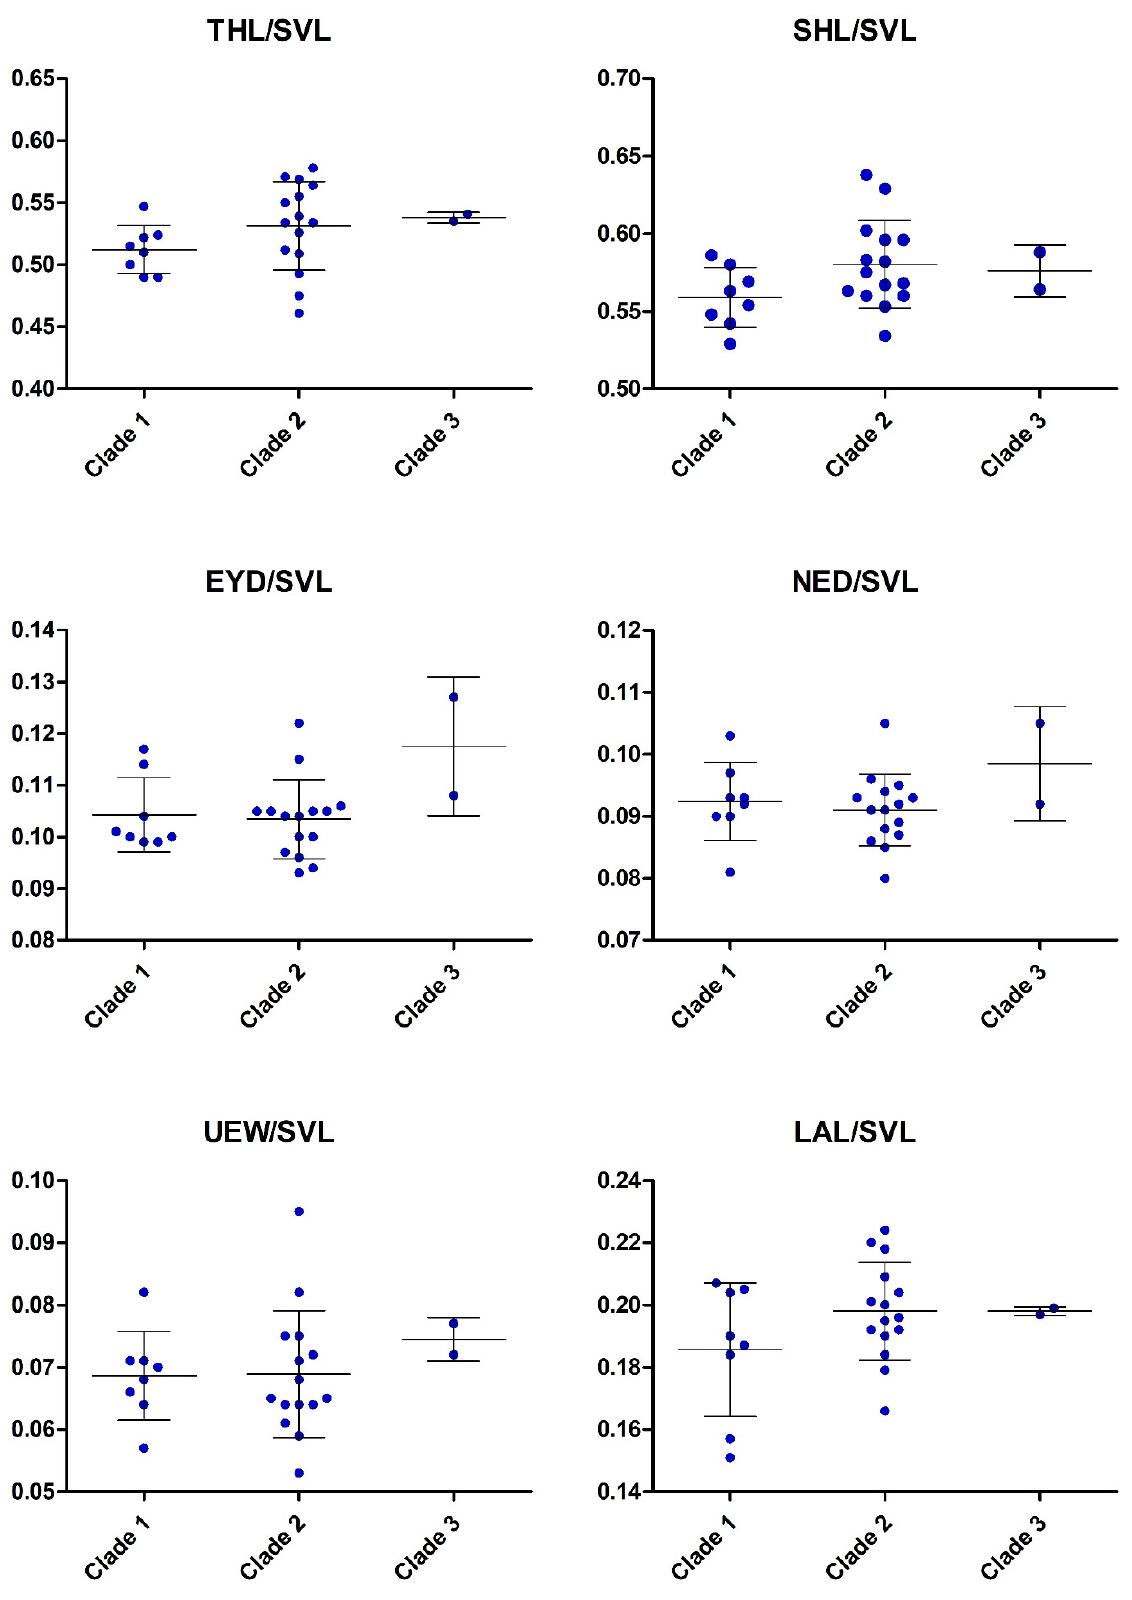
Figure 5. Scatter plots illustrating morphological variation in the clades frogs related to Limnonectes doriae . M = males; F = females. For definitions of Clades and abbreviations of morphological characters see text.